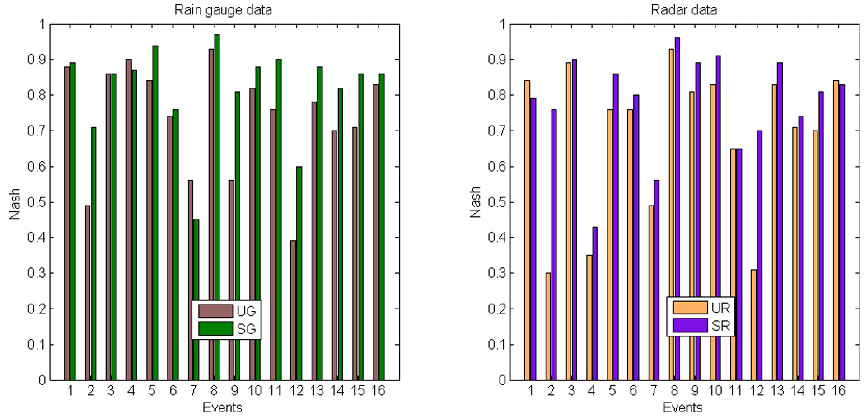
Fig. 7. Nash values for each event using uniform mean areal rainfall of spatially distributed rainfall from rain gauge data (left) or radar data (right). Table 3. Results of rainfall-runoff modeling using four different rainfall inputs (UG, UR, SG, SR). Rainfall RBIAS RBIAS RRMSE RRMSE Median input Volume PeakFlow Volume PeakFlow Nash (%) (%) (%) (%) UG − 0.05 − 0.20 0.20 0.22 0.77 UR − 0.07 − 0.19 0.14 0.23 0.76 SG − 0.10 − 0.13 0.15 0.19 0.86 SR − 0.07 − 0.12 0.13 0.19